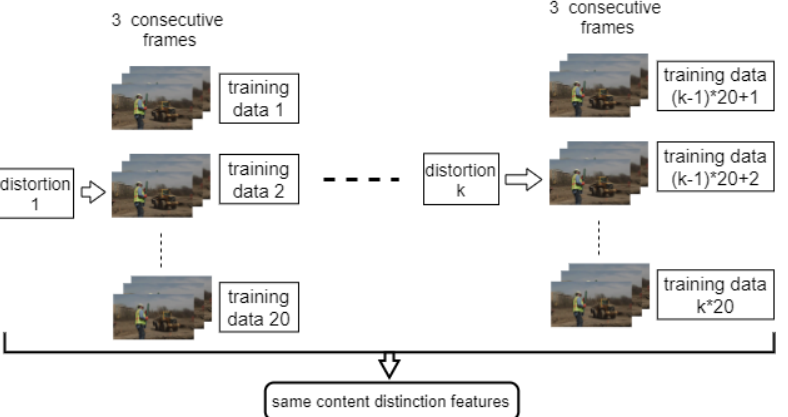
Figure 7. Preparing training data for videos with the same content (distorted from the same RAW video).